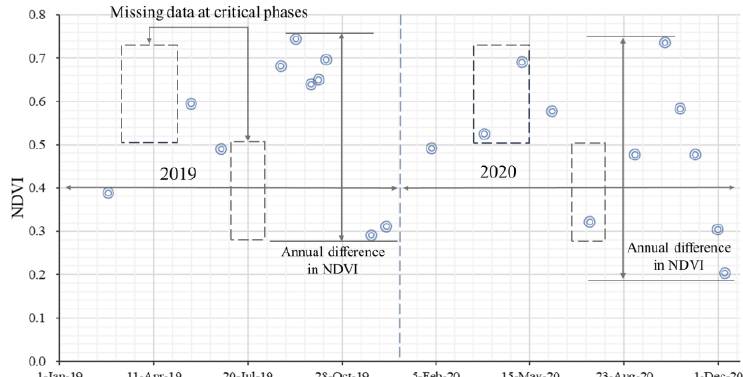
Figure 15. Temporal profile of NDVI for cultivated land without cloudless Landsat data during 2019 and 2020 (location: [109.7943, 20.8271]).